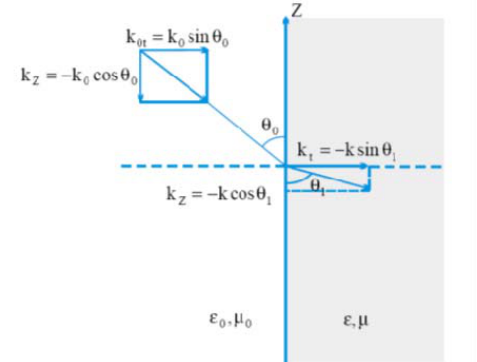
Figure 3: Longitudinal and transverse components of the incident and transmitted